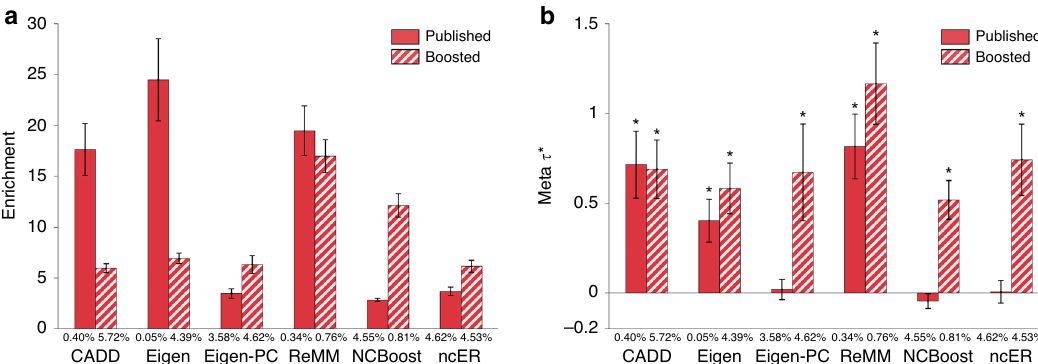
Fig. 2 Informativeness for a common disease of binary annotations derived from 6 genome-wide Mendelian disease-derived scores and corresponding boosted scores. We report ( a ) heritability enrichment of binary annotations derived from published and boosted genome-wide Mendelian disease-derived scores, meta-analyzed across 41 independent traits; b conditional τ * values, conditioning on the baseline-LD model (for annotations derived from published scores) or the baseline-LD model and corresponding published annotations (for annotations derived from boosted scores). We report results for six genome-wide Mendelian disease-derived scores (of six analyzed) for which annotations derived from published and/or boosted scores were